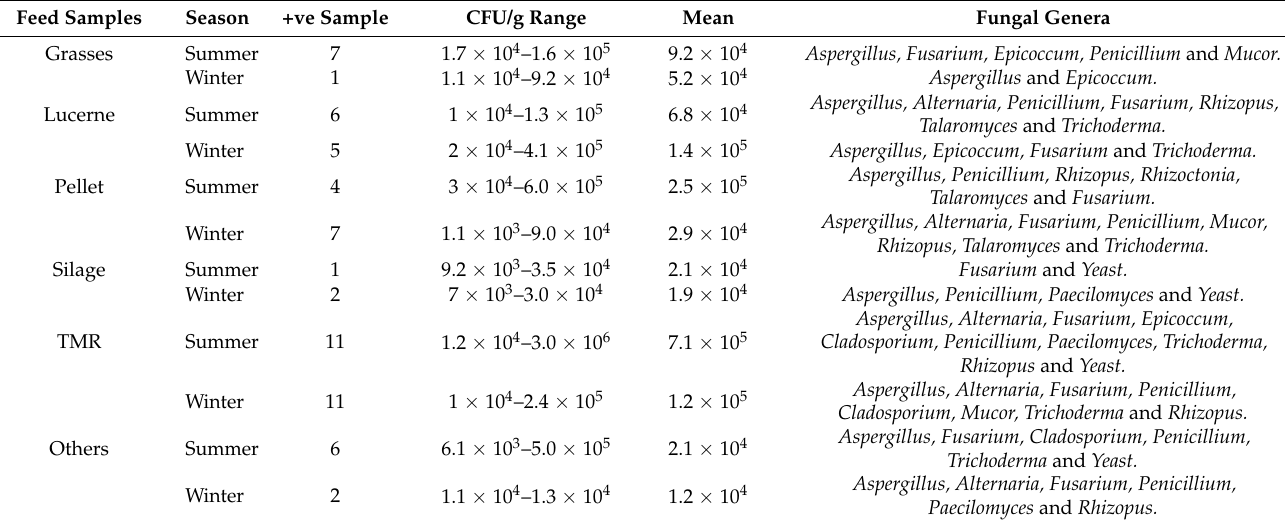
Figure 2. Phylogeny of Fusarium and Penicillium isolates (taxa names with triangles) from dairy cattle feeds based on ITS-region sequence homology. Numbers within the tree represent the bootstrap values of 1000 replicates. Table 1. Mean fungal loads and fungal genera recovered from smallholder dairy cattle feeds and feedstuffs from Free State and Limpopo provinces, South